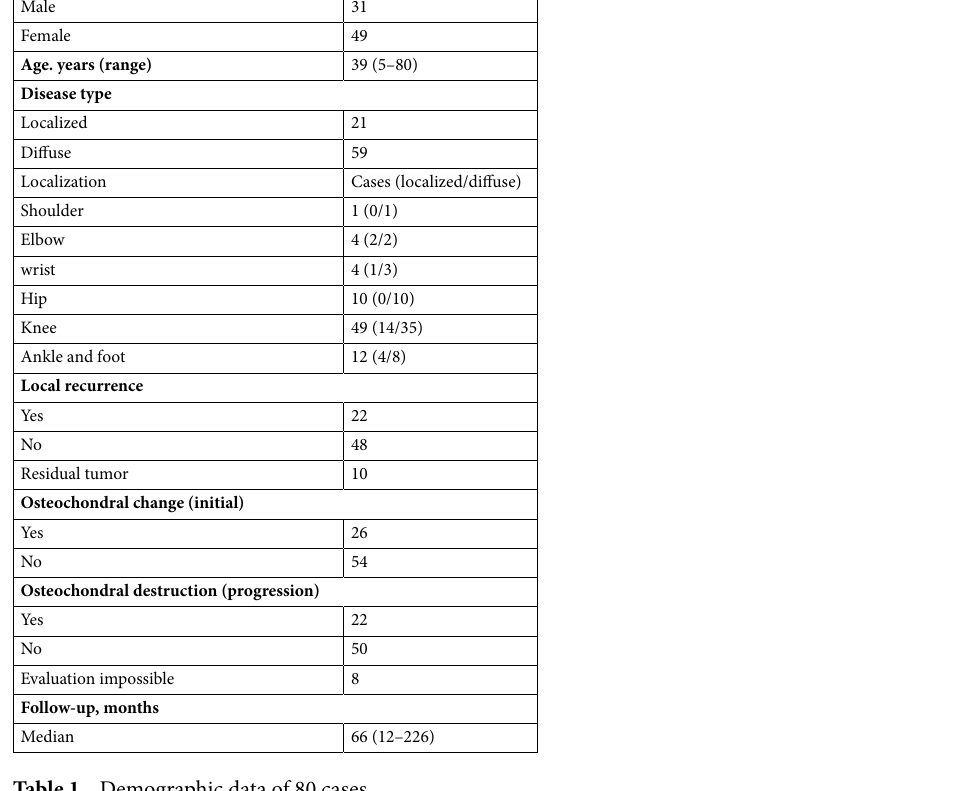
Table 1. Demographic data of 80